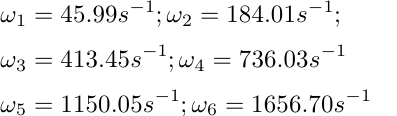
Fig. 4. Transverse cross section of the